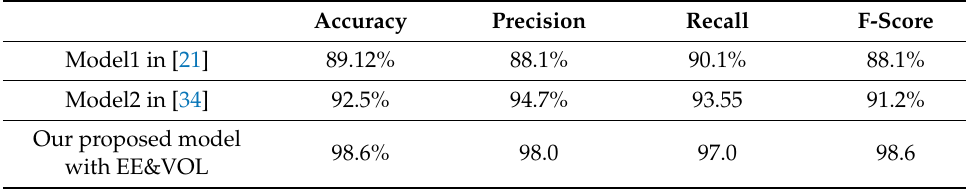
Table 6. Comparative study on the same datasets with transfer learning.